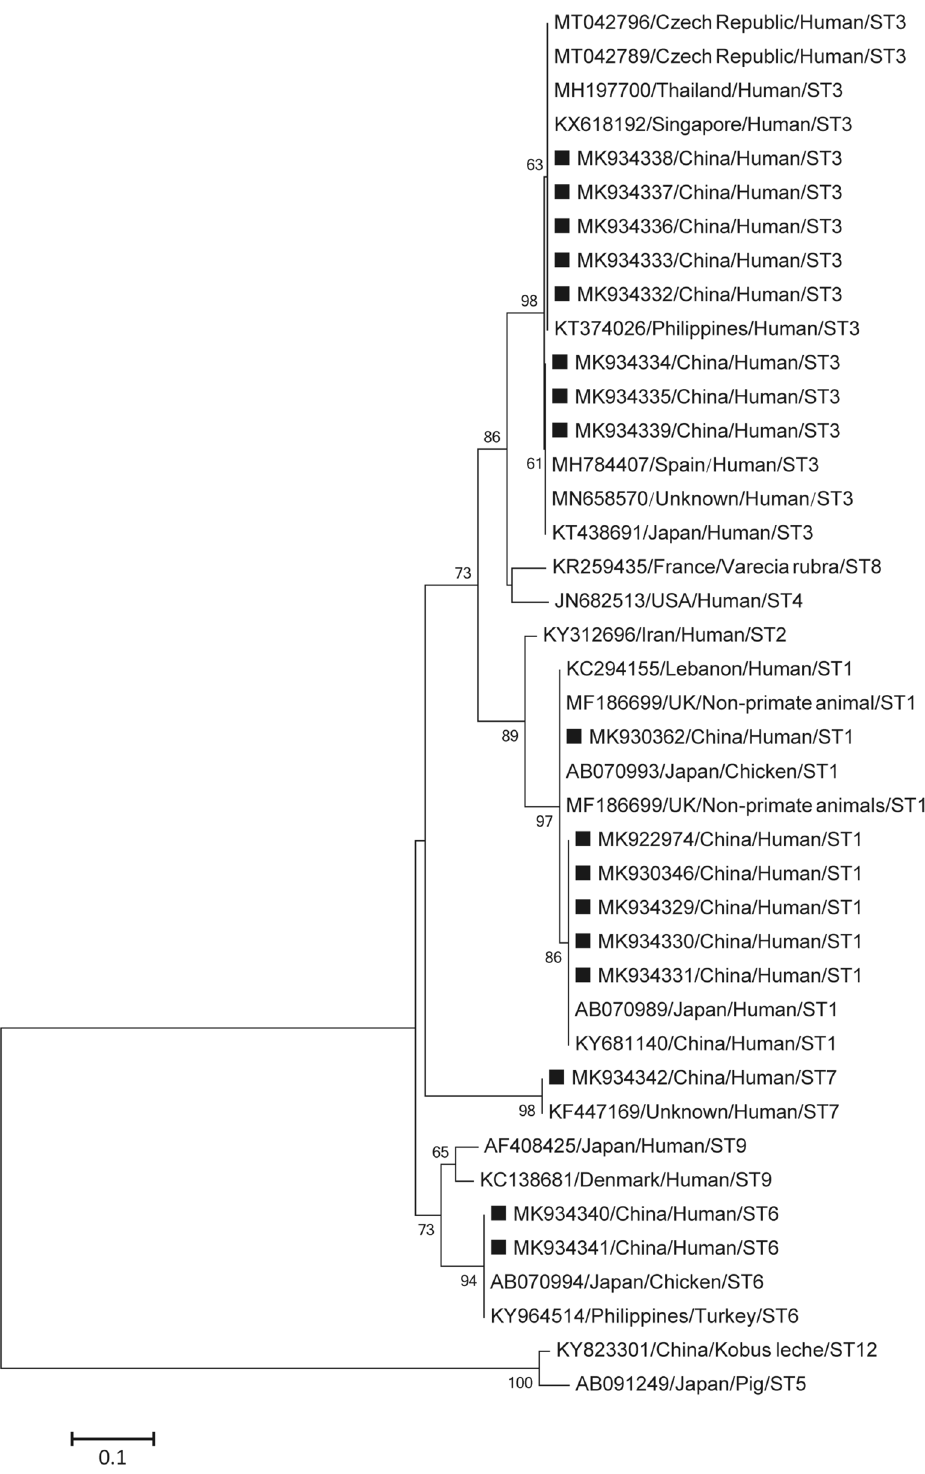
Figure 1. Phylogenetic tree of Blastocystis hominis based on the barcode region of the SSU rRNA gene sequence. MEGA 6.0 software (http:// www. megas oftwa re. net/) was used for this analysis, by applying the neighbor-joining distance method with 1000 bootstrap replicates. Individual GenBank accession numbers precede localities, followed by hosts and genotypes. The numbers on the branches are percentage bootstrapping values from 1000 replicates. The scale-bars indicate the number of substitutions per site. Squares indicate B. hominis identified from faecal DNA samples in this